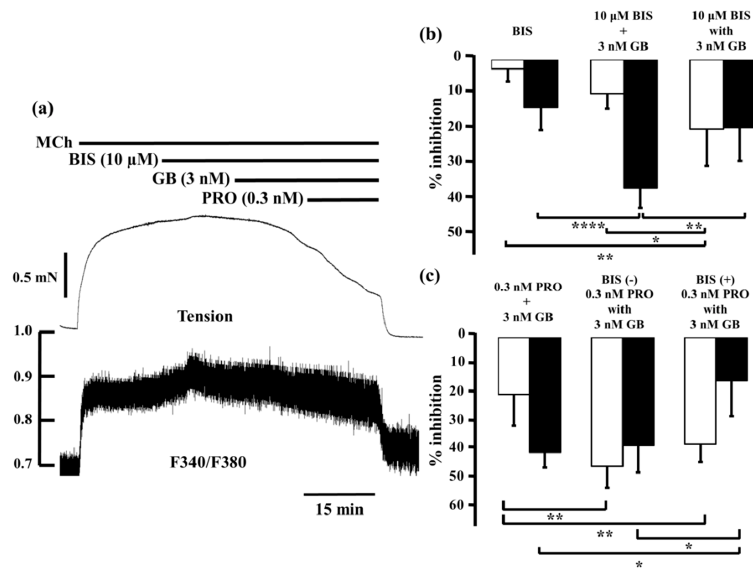
Figure 7. Involvement of protein kinase C-induced Ca 2+ sensitization in synergy between β 2 -adrenoceptor agonists and muscarinic receptor antagonists. ( a ) Typical record of tension ( upper side ) and F340/F380 ( lower side ) of the inhibitory effect in combination with procaterol (0.3 nM) and glycopyrronium (3 nM) in the presence of bisindolylmaleimide (10 μ M) against 1 μ M MCh-induced contraction. In each panel, percent inhibition of tension is represented by white columns, and F340/F380 is represented by black columns; ( b ) Left , percent inhibition in tension and F340/F380 by bisindolylmaleimide (10 μ M); Center , sum of percent inhibition of tension and F340/F380 with bisindolylmaleimide (10 μ M) and glycopyrronium (3 nM); Right , percent inhibition of tension and F340/F380 with combination of bisindolylmaleimide (10 μ M) and glycopyrronium (3 nM); ( c ) Left , sum of percent inhibition of tension and F340/F380 with procaterol (0.3 nM) and glycopyrronium (3 nM); Center , percent inhibition of tension and F340/F380 in combination with procaterol (0.3 nM) and glycopyrronium (3 nM); Right , percent inhibition of tension and F340/F380 with combination of